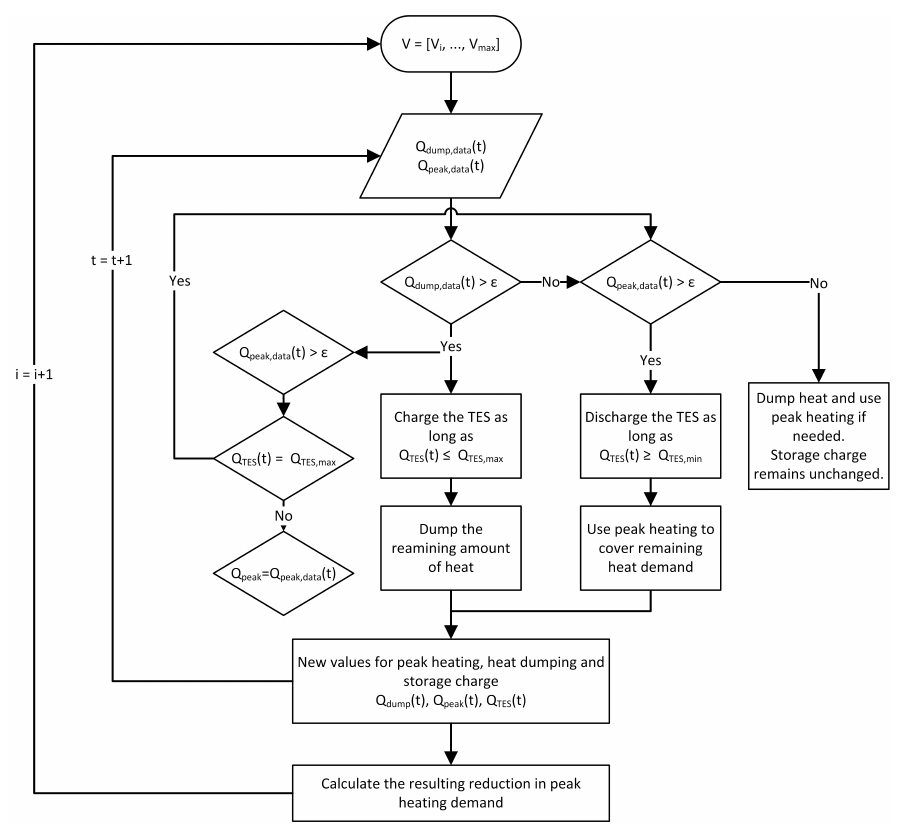
Figure 3. Approach for calculating the reduction in peak heating at different tank